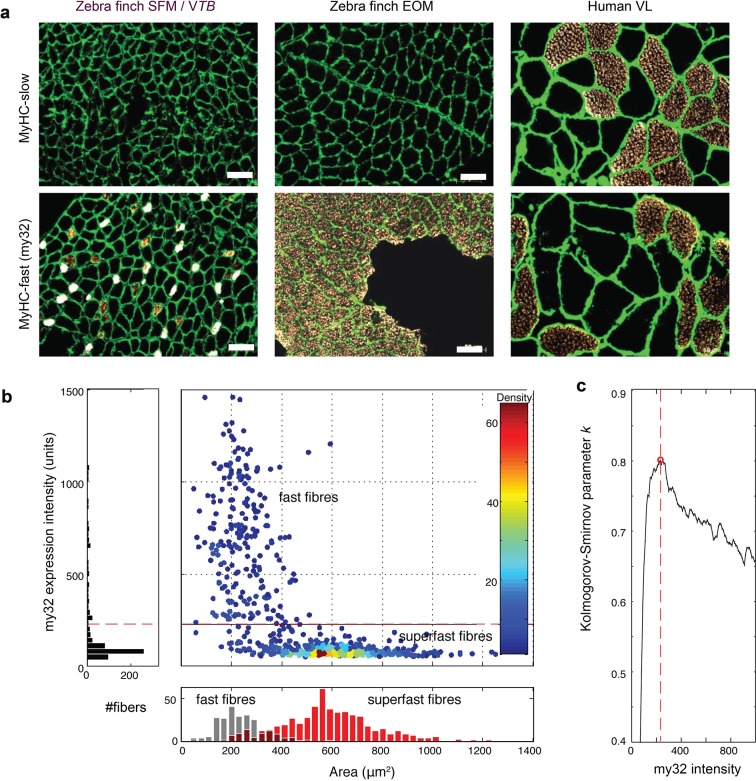
Zebra finch SFM contains two fiber type populations.(a) Labeling of slow and fast (MY-32) myosin antibodies in adult male zebra finch SFM shows that it contains some myofibrils that express or co-express fast MYH genes, but predominantly fibers that do not react. The latter fibers express the avian MYH13 ortholog. (b) FACS analysis of 801 cells of 4 individuals showing the two fiber populations separate c) best at intensity of 220 as shown by a Kolmogorov-Smirnov test.